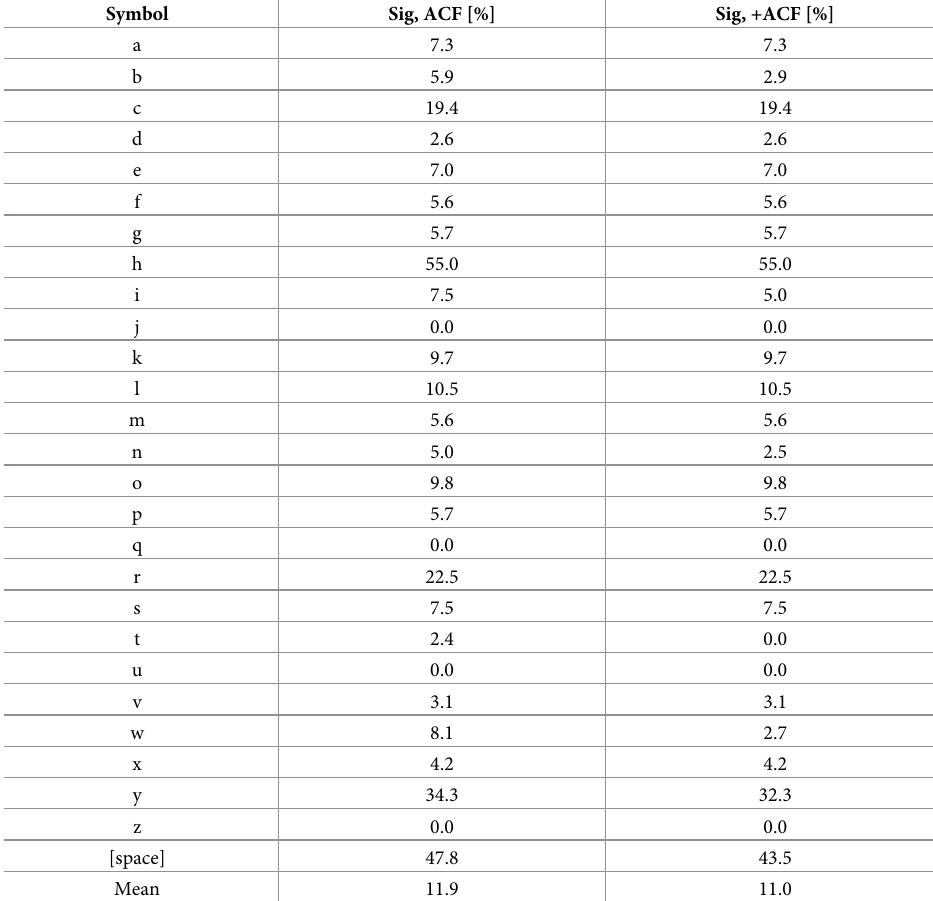
Table 2. Summarization of ACF analysis of individual symbols of a single English